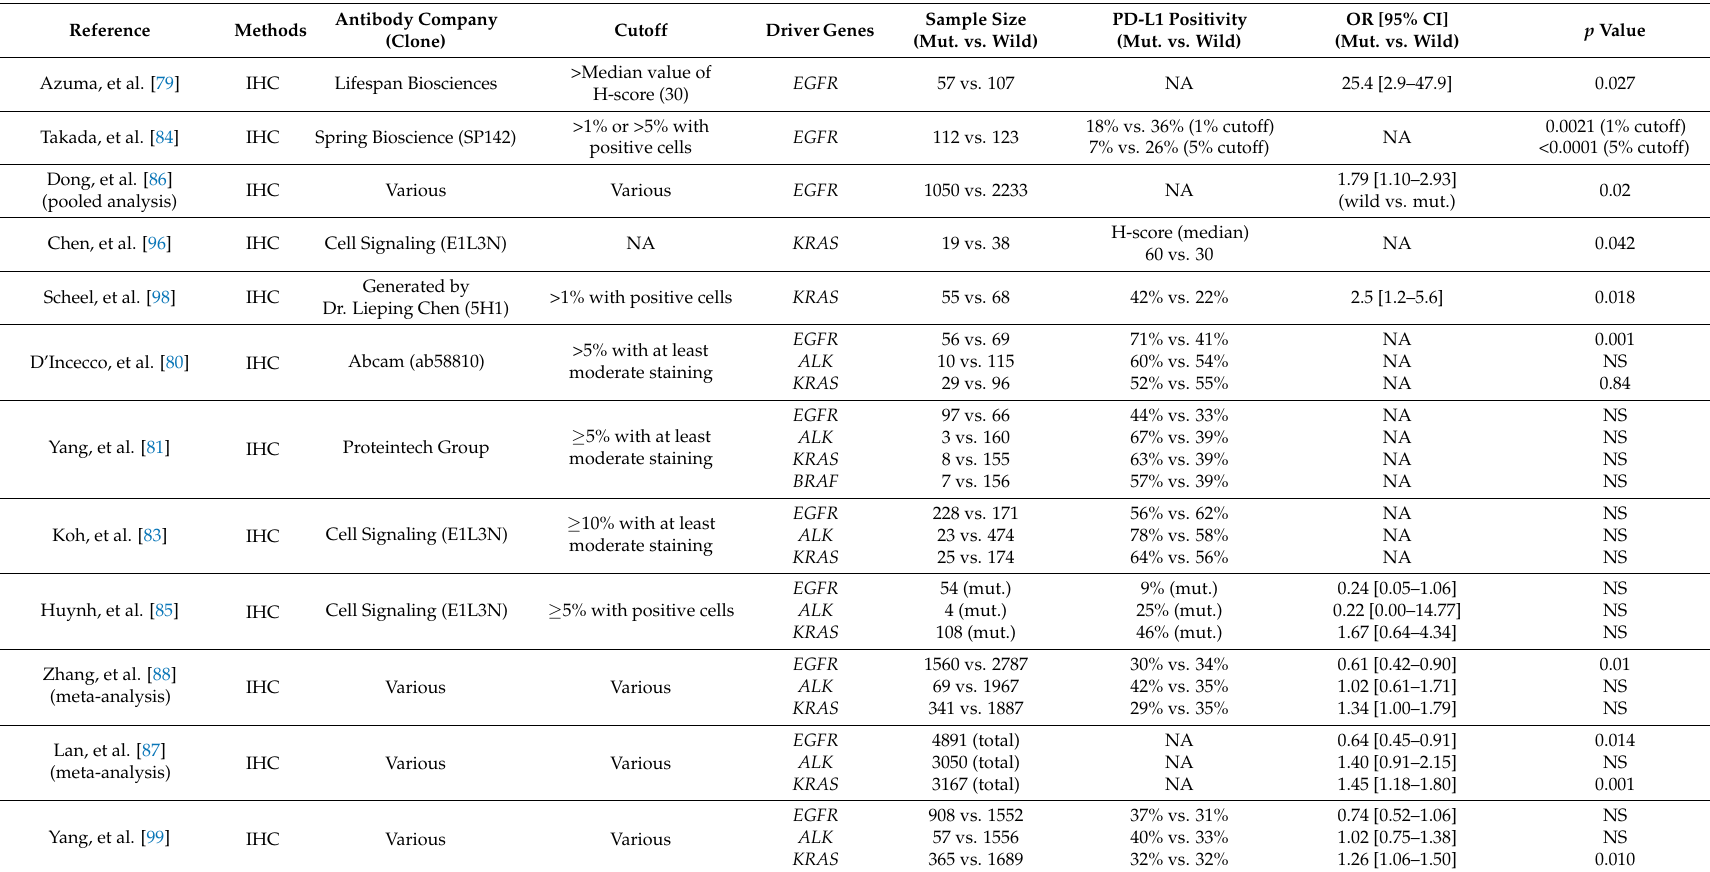
Table 2. Programmed death-ligand 1 (PD-L1) expression according to status of oncogenic